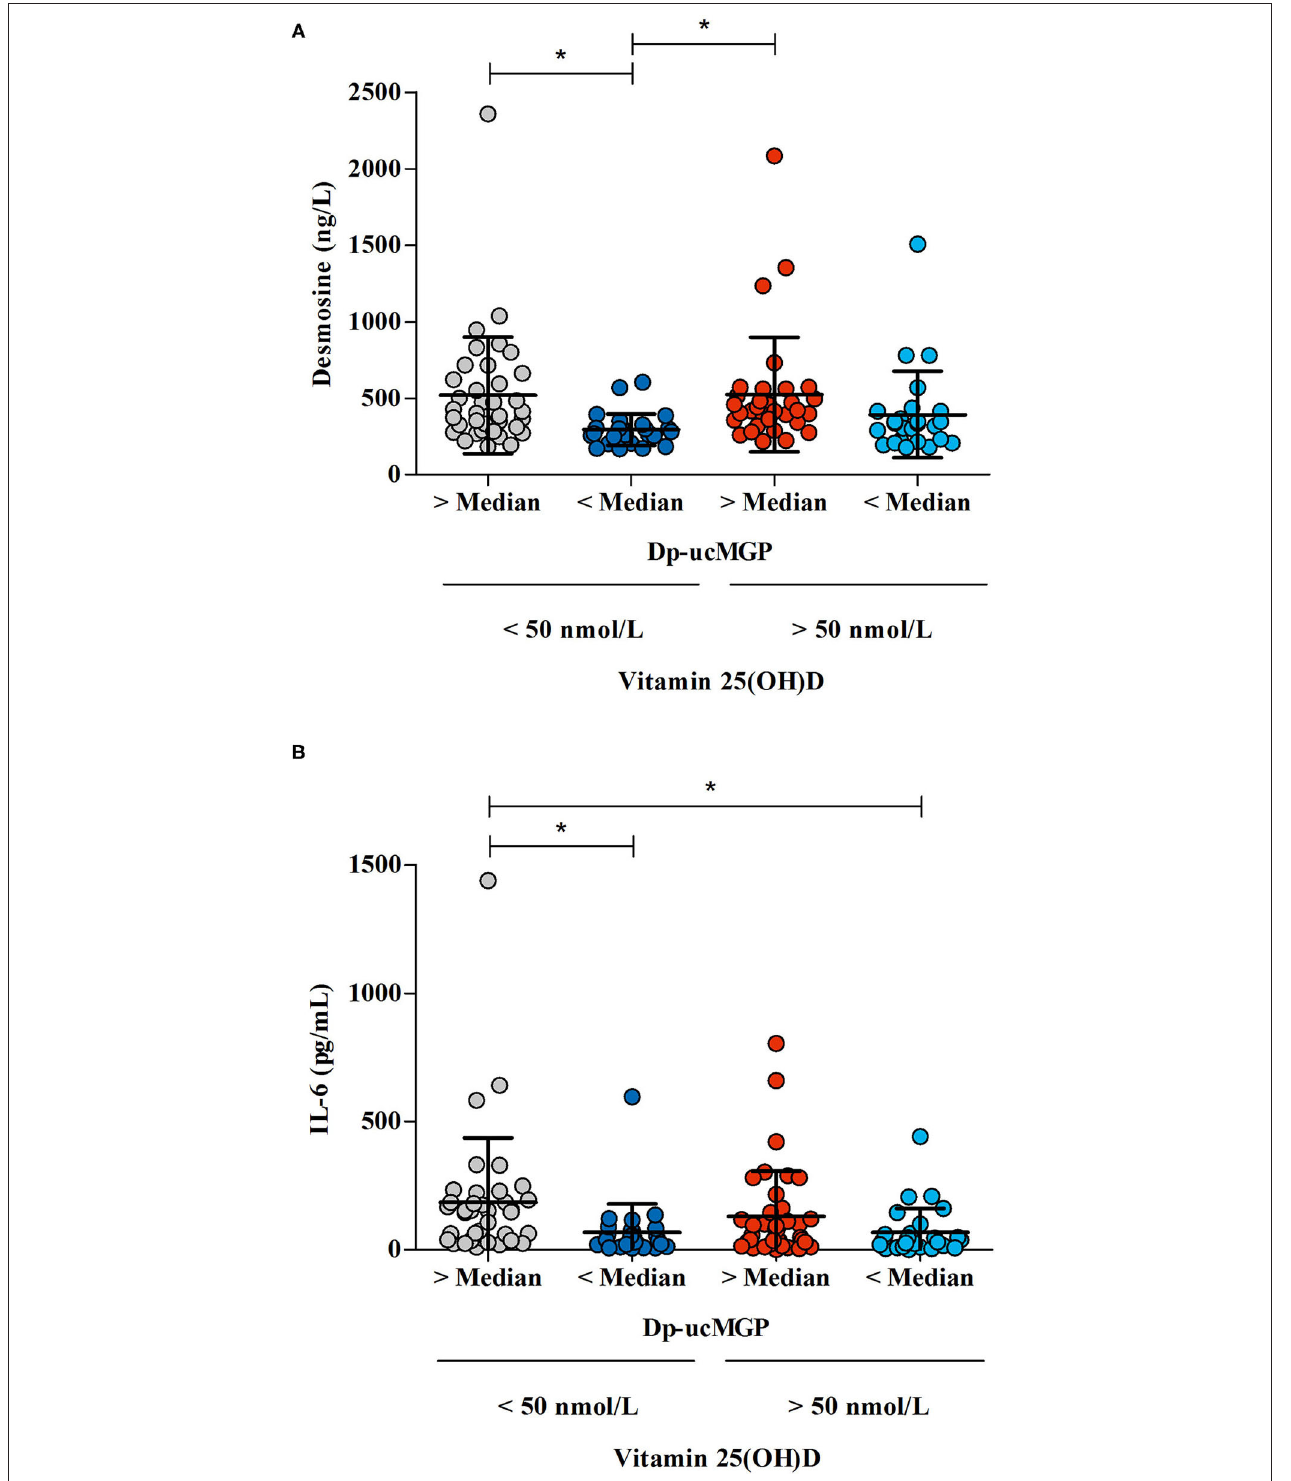
FIGURE 4 | The association between the differences in vitamin K status /vitamin D status /desmosine and IL-6 levels in COVID-19 patients. Vitamin K levels were defined as “low” when dp-ucMGP levels were above median, and “high” when dp-ucMGP levels were below median. Vitamin D levels were defined as “low” when there was a 25(OH)D insufficiency (concentration < 50 nmol/L) and “high” when there was a sufficient amount of vitamin D (concentration > 50 nmol/L). (A) The effect of vitamin K status — derived from dp-ucMGP status — on desmosine levels in patients with high or low vitamin D levels. Desmosine levels were measured in 122 patients. (B) The effect of vitamin K status — derived from dp-ucMGP status — on IL-6 levels in patients with high or low vitamin D levels ( n = 131). * Indicates significant difference between groups.